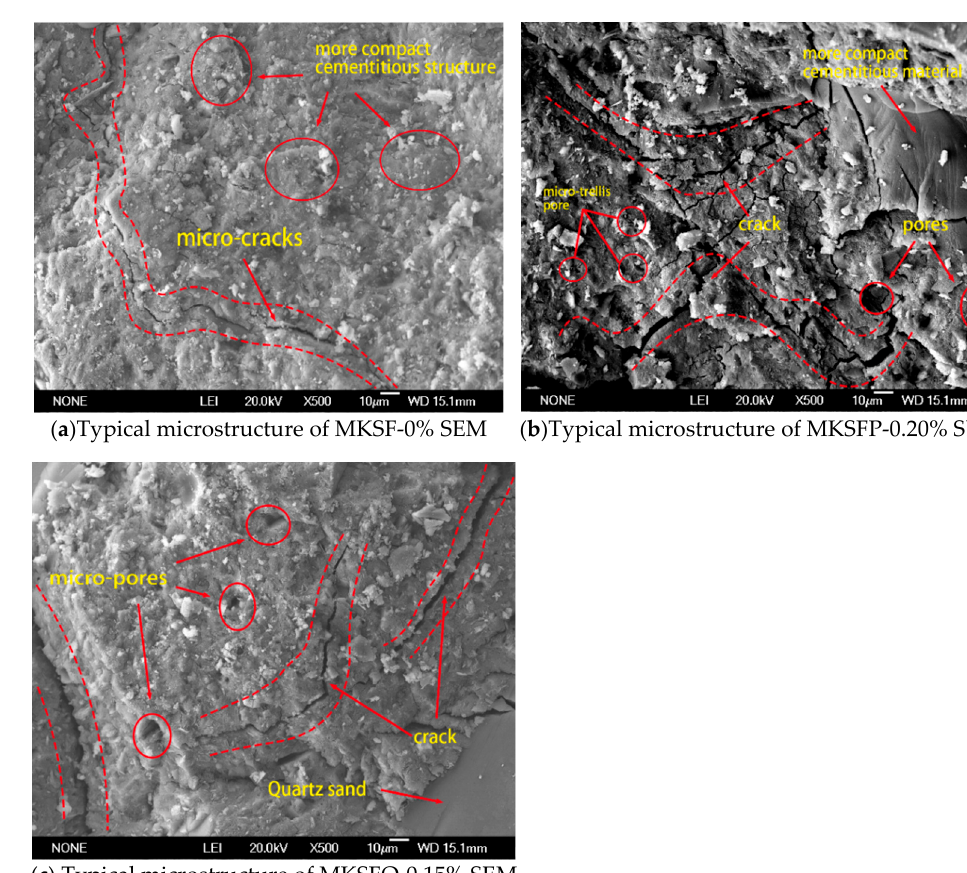
Figure 12. Microstructure of reference group and defoamer group.